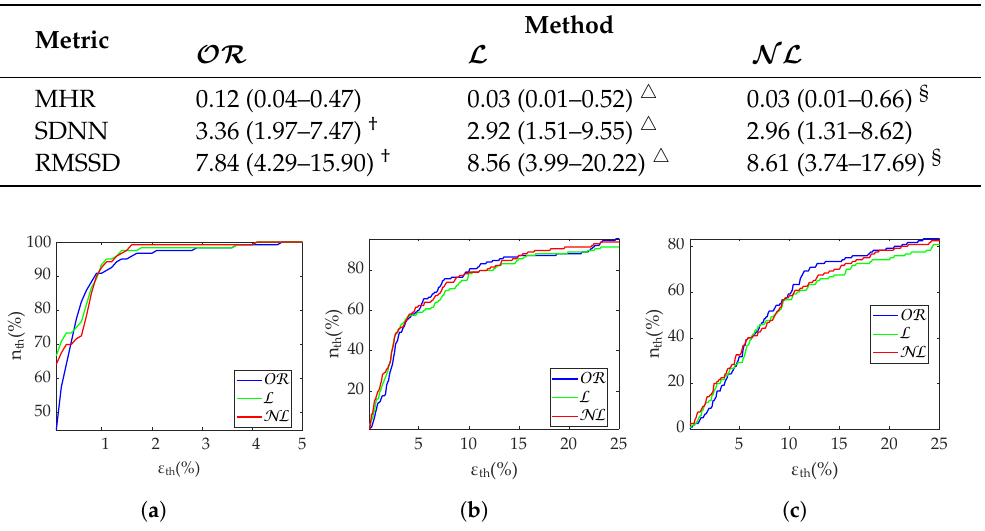
Table 3. Relative error (%) of time-domain metrics from Apple Watch dataset. †: Significant dif- ferences ( p < 0.05) between OR and L . (cid:52) : Significant differences ( p < 0.05) between L and N L . §: Significant differences ( p < 0.05) between N L and OR .